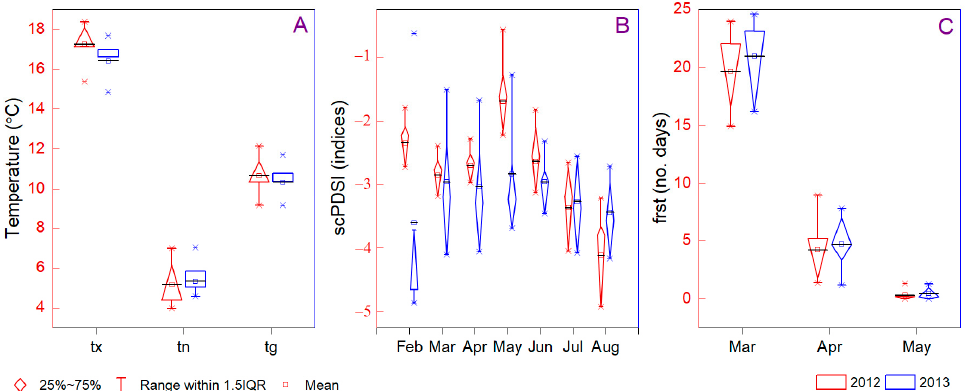
Figure 1. Mean climate differences between 2012 and 2013, according to the mean yearly record of each data grid; ( A ) temperatures; ( B ) self-calibrating Palmer Drought Severity Index; ( C ) ground frost day frequency. The 2012 (red) and 2013 (blue) values are